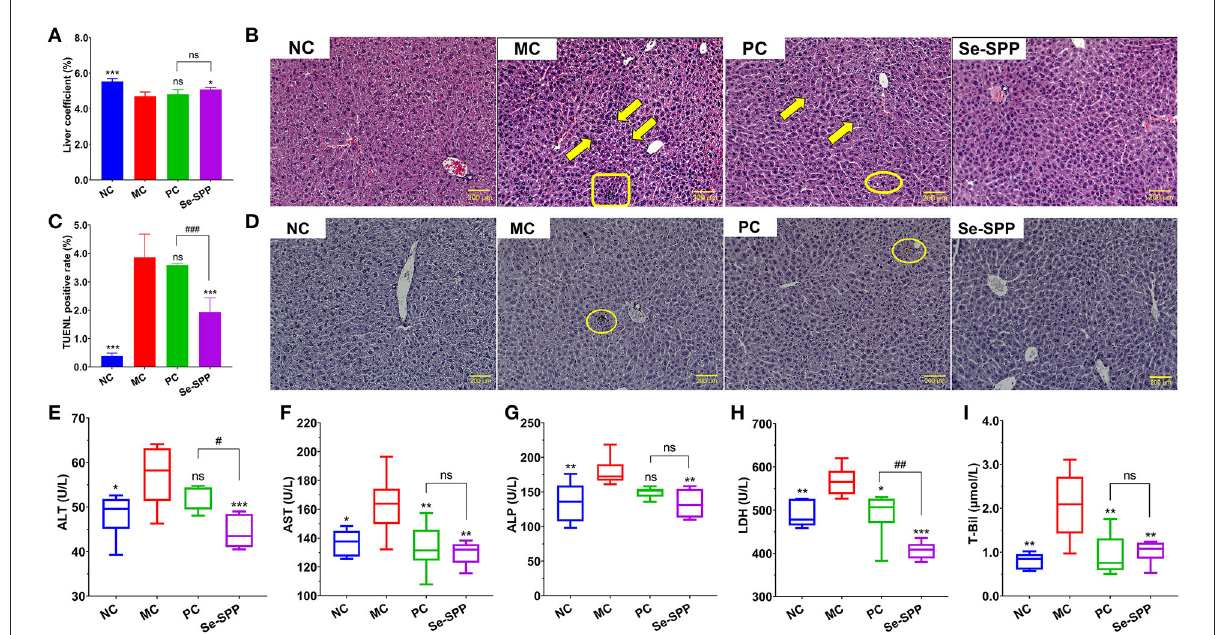
FIGURE1 Se-SPP alleviates Cd-induced liver injury in mice. Liver coefficient (A) . Images of H&E-stained liver [ (B) , 20 × ], karyopyknosis (arrow), punctate necrosis (circle), and inflammatory cell infiltration (rectangle). The TUNEL staining of hepatic cells (C,D) and serum T-Bil, ALT, AST, ALP, and LDH levels (E–I) . ALT, alanine transaminase; AST, aspartate aminotransferase; ALP, alkaline phosphatase; LDH, lactate dehydrogenase; T-Bil, total bilirubin; NC, normal control; MC, model control; PC, positive control; Se-SPP, selenium-containing polysaccharides from Spirulina platensis . Data are expressed as mean ± SEM ( n = 6). Graph bars marked with ns: not significant, * p < 0.05, ** p < 0.01, *** p < 0.001, when comparing with MC, # p < 0.05, ## p < 0.01, ### p < 0.001 when comparing PC with